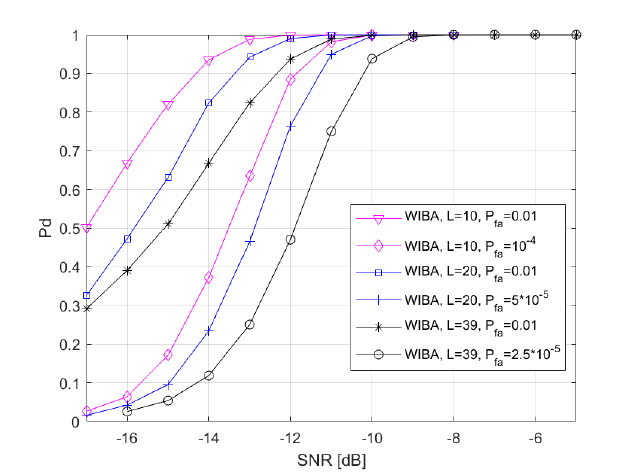
Figure 14. Probability of detection vs. SNR [dB] in AWGN channel. The signal bandwidth is 5% ( L = 39 ), 10% ( L = 20 ) and 20% ( L = 10 ).